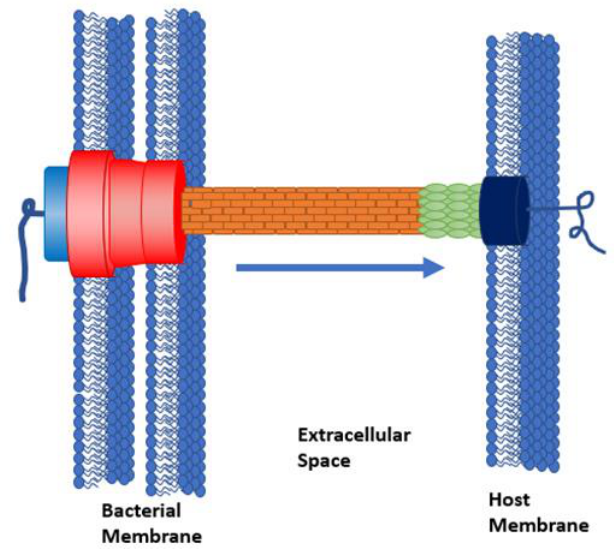
Figure 1. Structure of the type III secretion system (T3SS).